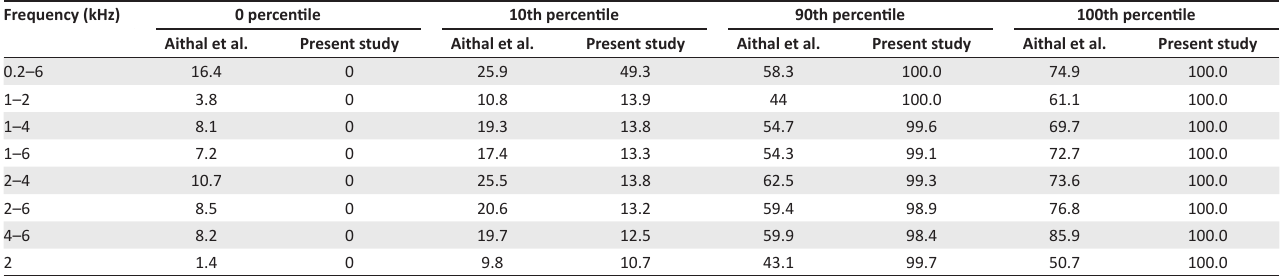
FIGURE 3: A comparison of the reflectance values measured in the present study. TABLE 4: Reflectance area indices of infants in the present study ( n = 75) compared to those reported by Aithal et al. (2013) ( n =